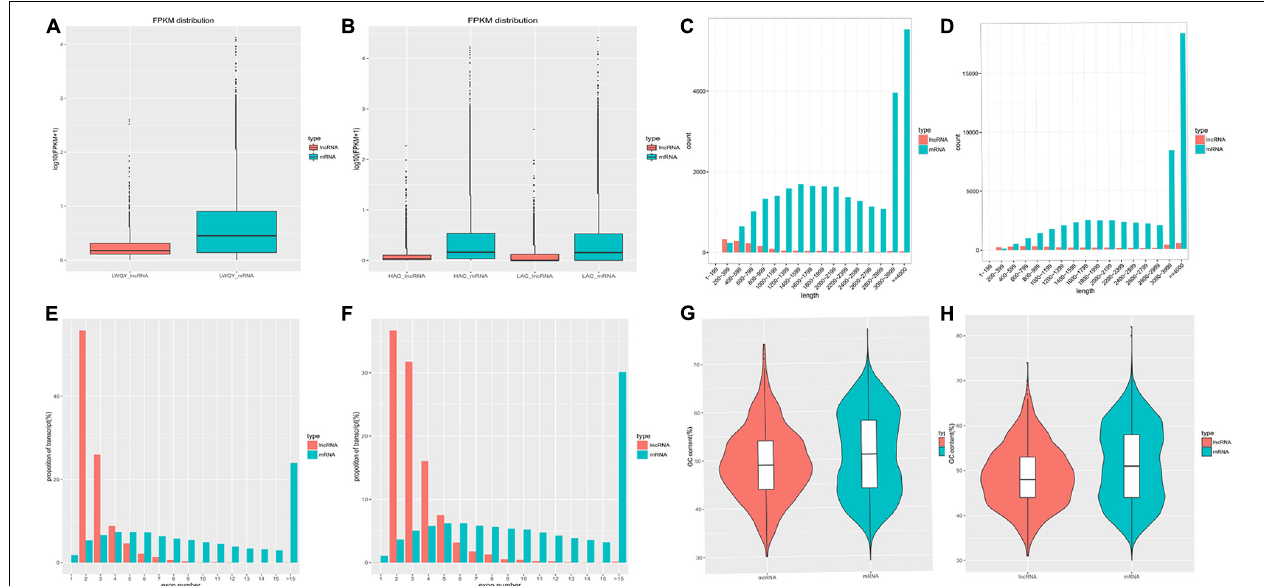
FIGURE 3 | The protein-coding and lncRNA transcripts characteristics in the yak and cattle hearts. (A,B) FPKM (Fragment Per Kilobase of transcript per Million mapped reads) for protein-coding and lncRNA transcripts in LWQY (A) and cattle (B) . (C,D) The distribution of read lengths for protein-coding and lncRNA transcripts in LWQY (C) and cattle (D) . (E,F) The proportions of exons per transcript for protein-coding and lncRNA transcripts in LWQY (E) and cattle (F) . (G,H) The GC contents of protein-coding and lncRNA transcripts in LWQY (G) and cattle (H) .